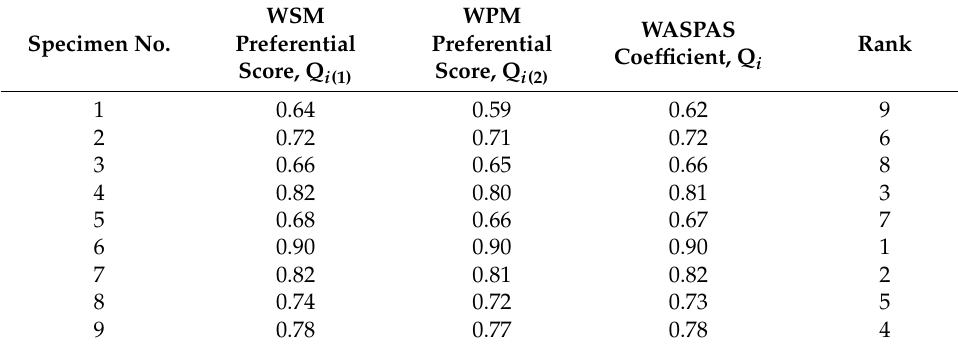
Table 11. Ranking of alternatives.